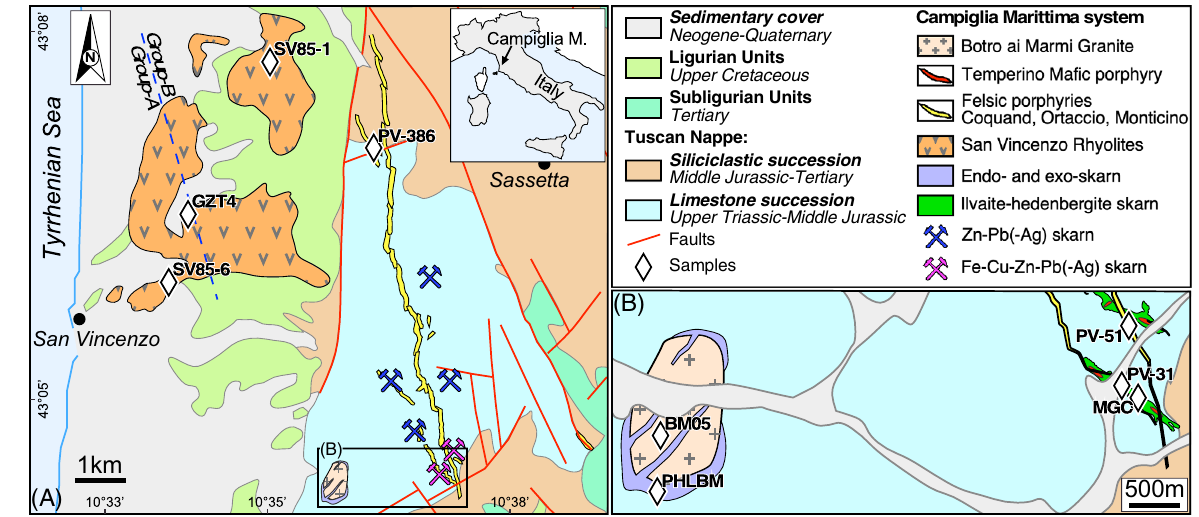
Figure 1. ( A ) Geological map of the Campiglia Marittima area showing the location of the investigated samples modified after Vezzoni et al. 28 . ( B ) Close up of the southern zone of the investigated area. The dashed line separating Group-A from Group-B rhyolites (San Vincenzo Rhyolite) is from Pinarelli et al. 46 . (Figure generated by Canvas x draw v.